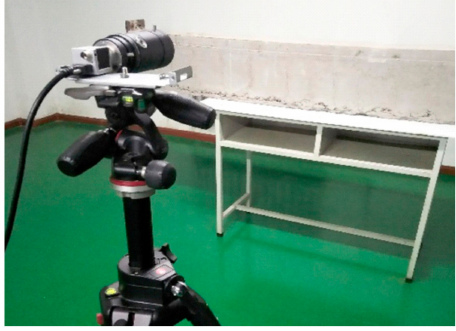
Figure 17. The image acquisition system.